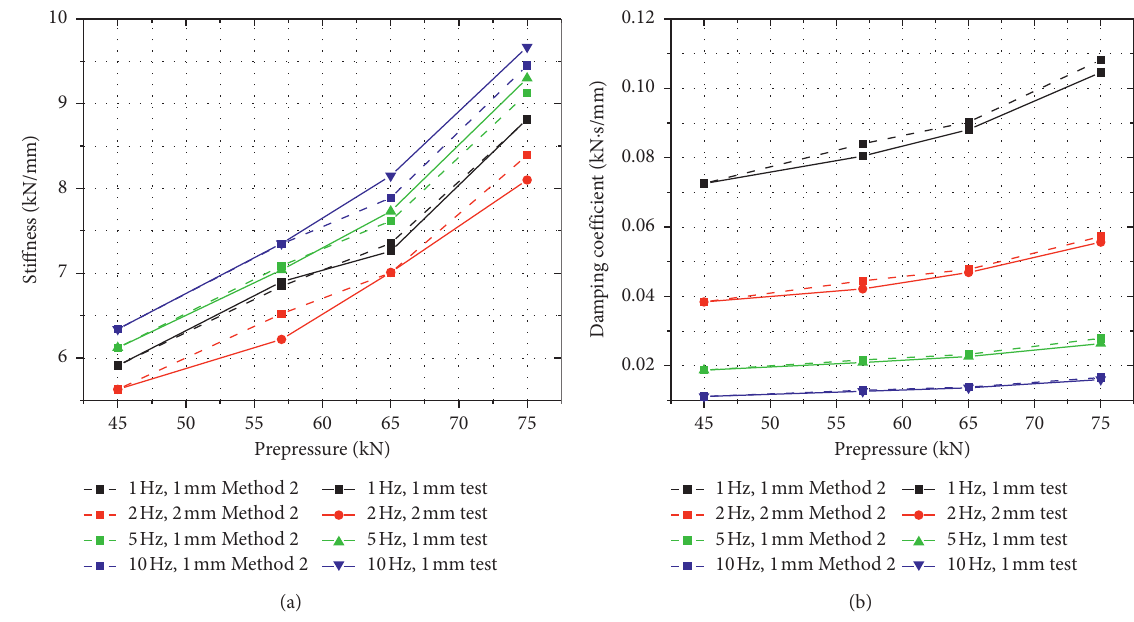
Figure 13: Comparison between Method 2 and test